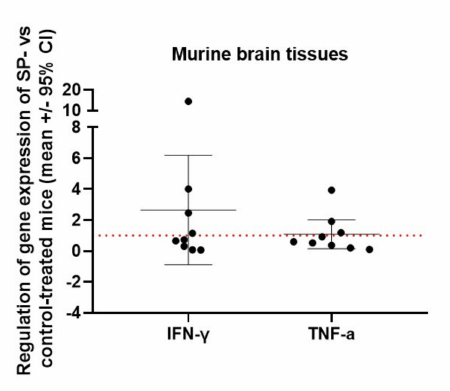
Figure A3. E ff ect of SP treatment on relative cytokine mRNA expression in murine brains of EAE-diseased mice (acute phase). X-fold di ff erence in the relative expression of interferon gamma (INF- γ ) and tumor necrosis factor alpha (TNF- α ) (normalized to Rps18) in SP 30 mg / kg / day-treated mice compared to control mice. Control ( n = 9, in triplicates), SP 30 mg / kg / day ( n = 9, in triplicates) and 3 days of treatment. qRT-PCR. Abbreviations: SP: SP600125 and CI: confidence of interval. Statistic: one-sample t -test: n.s.